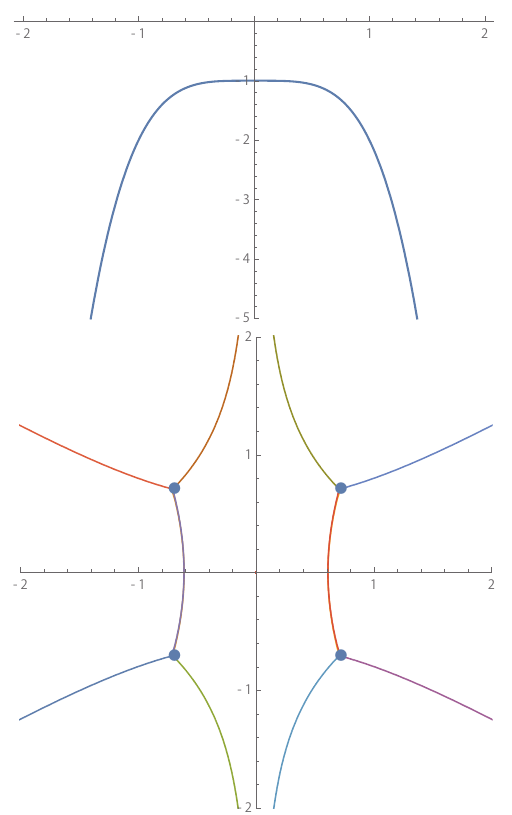
Figure 4 . The potential ( V ( x ) = − 1 − x 4 on the V − x -plane) is shown in the upper panel, and the Stokes lines (for Q ( x ) = − 1 − x 4 on the complex x -plane) are shown in the lower panel. One can see two characteristic structures (called “MTP”). The Stokes phenomena (particle production) occur when the real axis of time crosses the Stokes line. In this case, the special function that gives the exact solution is not known. However, from the Stokes lines, one can calculate the connection matrices using the